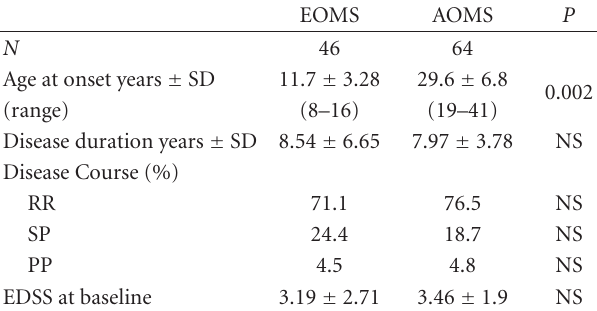
Table 1: Comparison of demographic features of EOMS and AOMS at baseline.